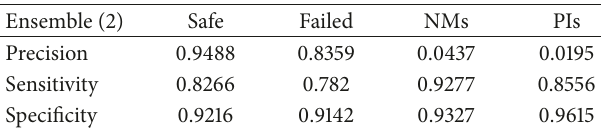
Table10:Locallyweightedensembleperformanceparametersusing (13).